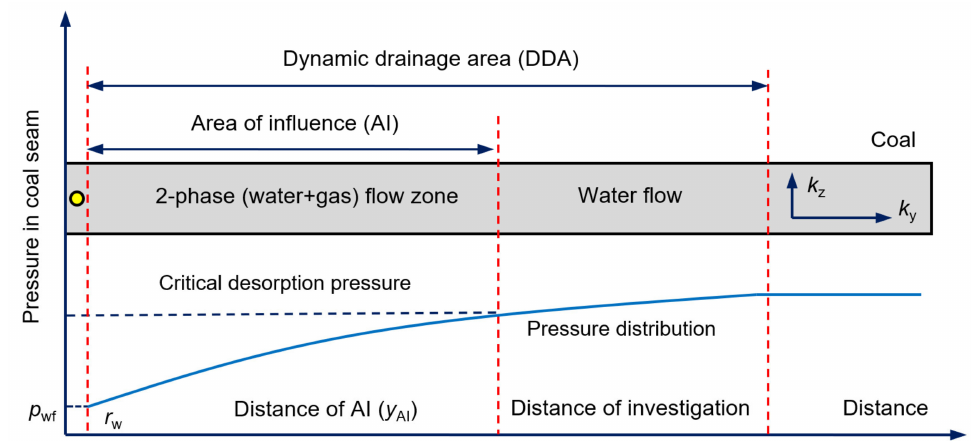
Figure 2. The AI and DDA of the transient formation linear flow regime of a horizontal well in an under-saturated CSG